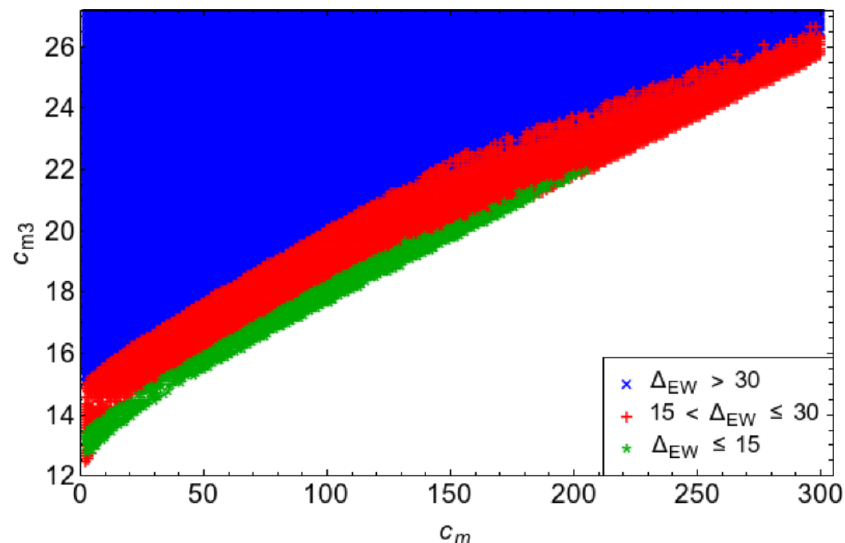
Figure 4 . Allowed (colored) points in c m 3 vs. c m